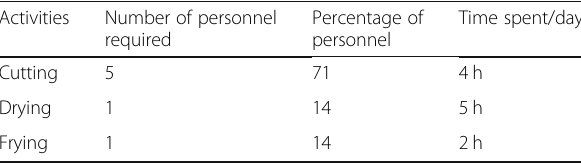
Table 2 Labour division and time required for processing 50 kg of koche